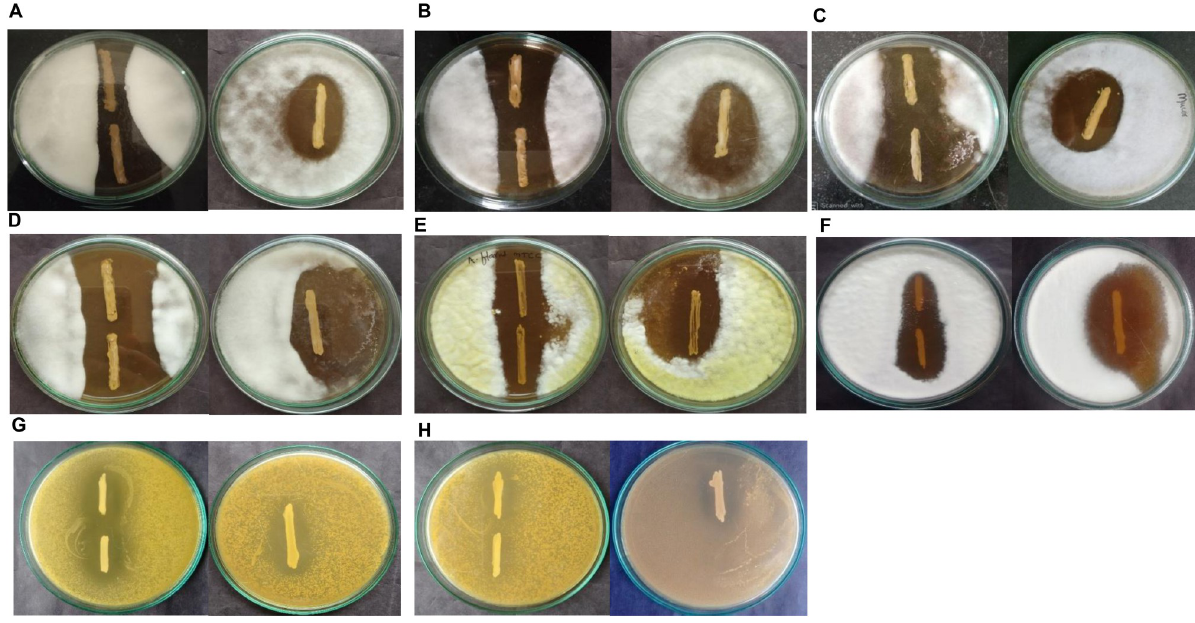
Fig 4. Antifungal activity of two L . pentosus strains and one P . acidilactici against fungal pathogens by agar over lay method (A) Rhizopus arrhizus MTCC 24794, (B) Rhizopus sp., (C) Mucor sp. 1, (D) Mucor sp. 2, (E) Aspergillus flavus MTCC 2788, (F) Fusarium oxysporum , (G) Candida albicans , (H) Candida tropicalis